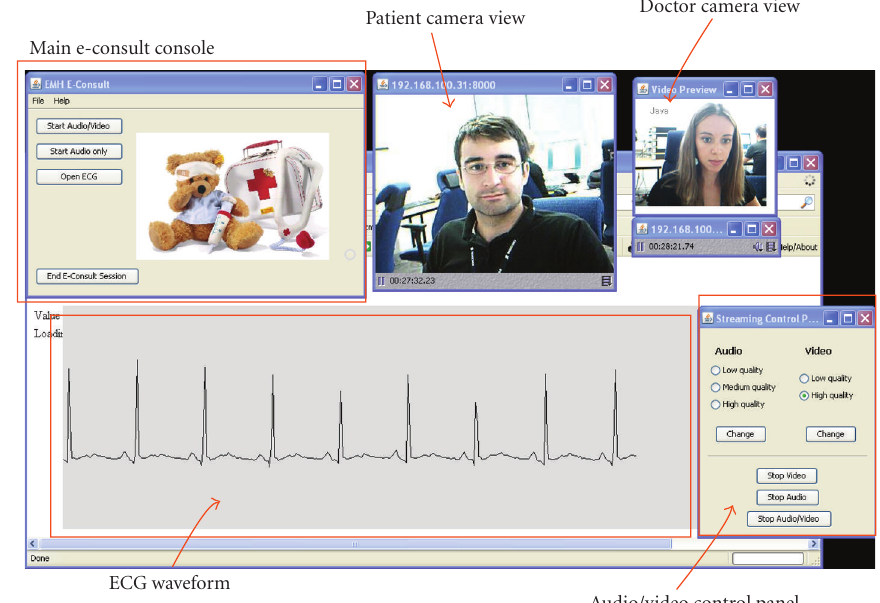
Figure 4: Early research prototype tele-consultation service—doctor desktop